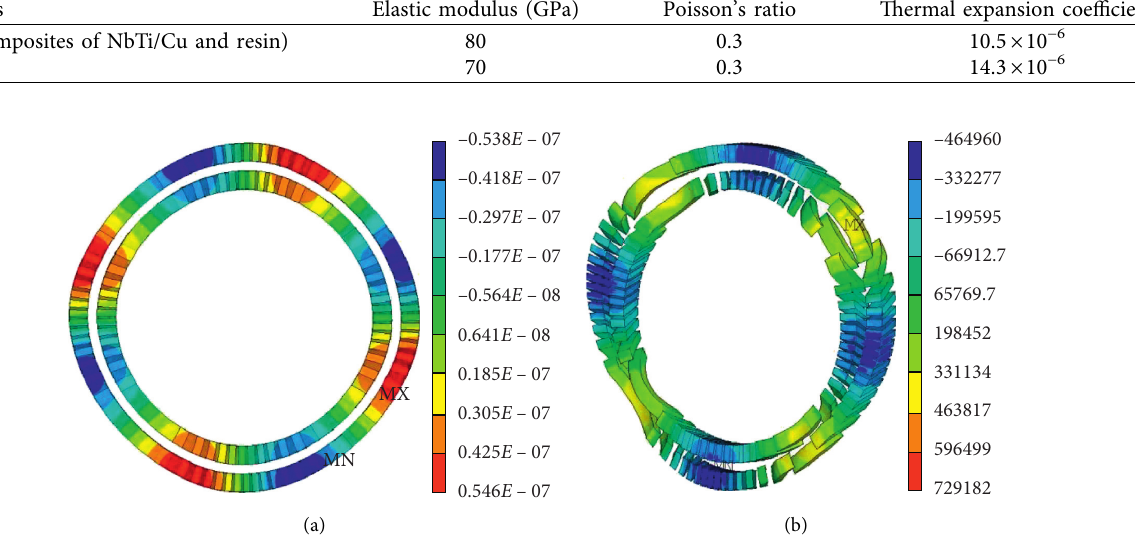
Figure 8: The displacement (a) and equivalent stress (b) distributions of the CCT quadrupole magnet under the Lorentz force.